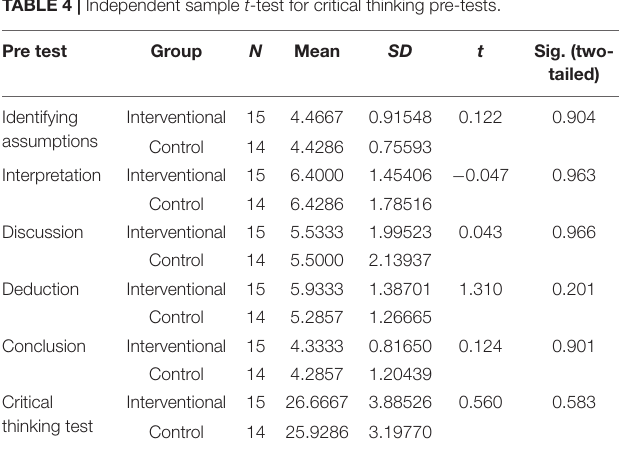
TABLE 4 | Independent sample t -test for critical thinking